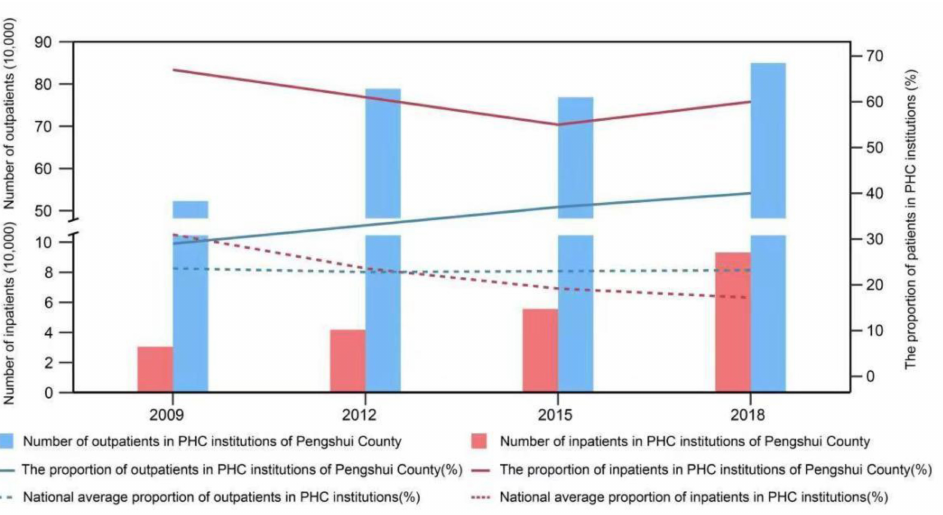
Figure 3. Comparison of visits to Pengshui’s PHC institutions, 2009–2018. Source: Health Statistics Yearbook. The proportion of outpatients in PHC institutions (%) = number of patients who sought first-contact care in PHC institutions/number of patients in healthcare institutions at all levels. Primary health care =